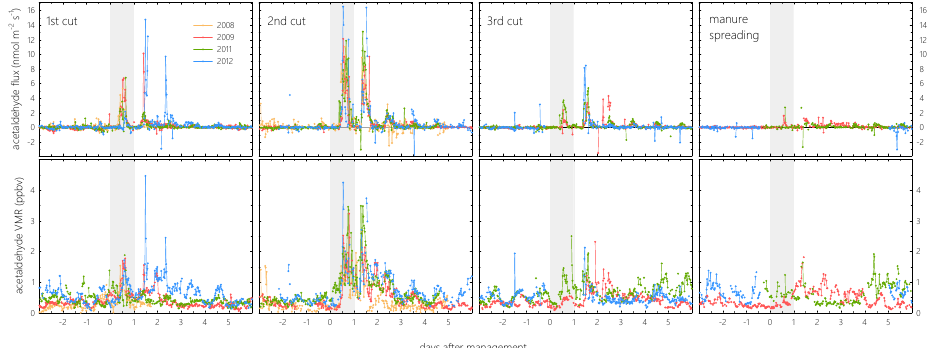
Figure 4. The influence of management events on acetaldehyde fluxes and volume mixing ratios (VMR) during 4 years of VOC measure- ments, the filled rectangle marks the day of the management